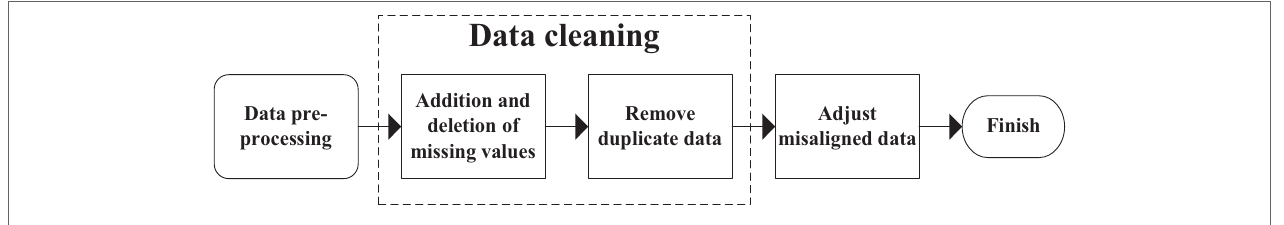
FIGURE 15 | Data pre-processing